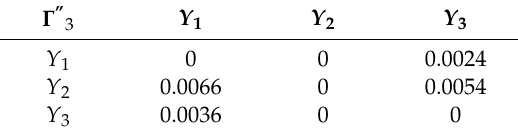
Table 35. The regret matrix Γ (cid:48)(cid:48) 3